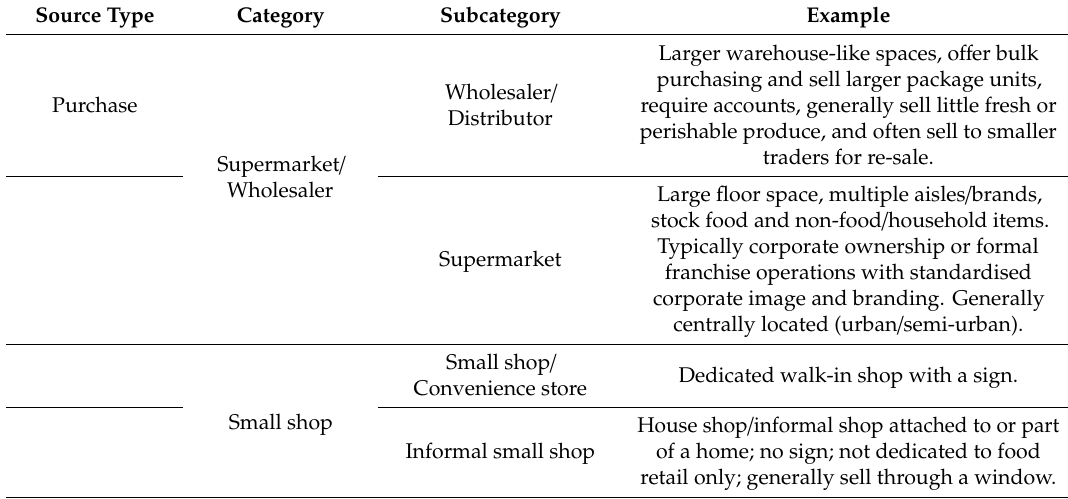
Table 1. Food source categories used for the Community Food and Health (CFaH)